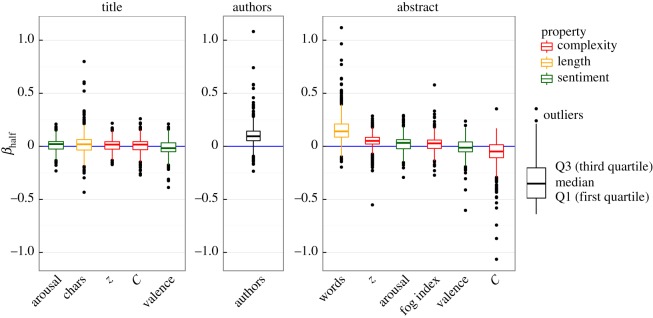
Strength of factors calculated over all journals. Box-plots (see definition on the right) summarize the distribution of βhalf values across different journals. Influential factors are identified as those for which ∣β∣ is large for almost all journals (e.g. when the box does not contain βhalf=0 line this implies that in at least 75% of the journals the value of βhalf is above or below zero).